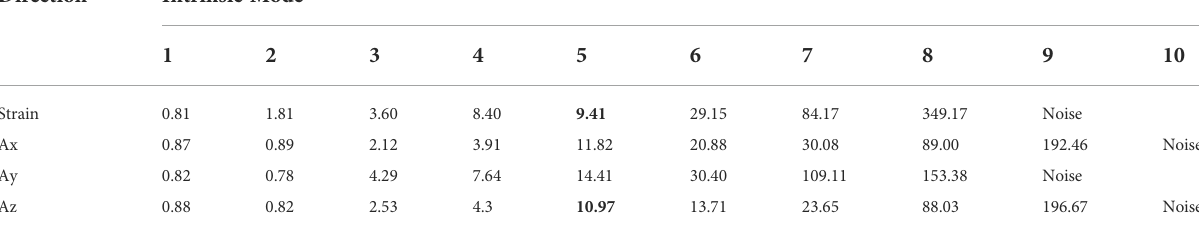
TABLE 2 Dominant frequencies for each periodic mode